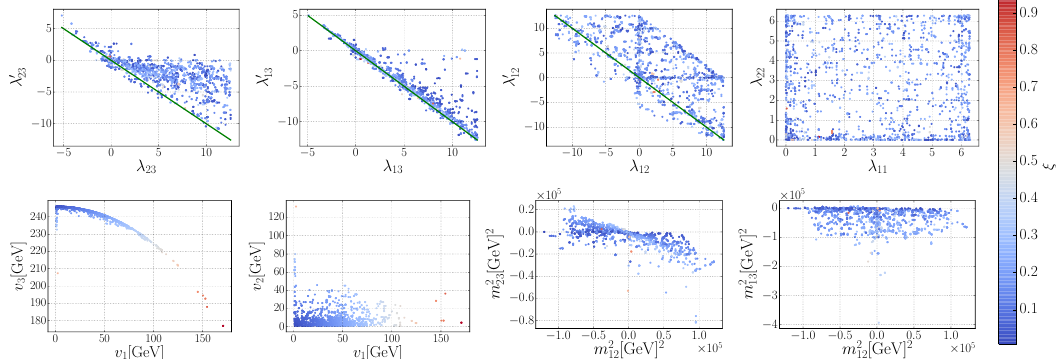
Figure 7 . Distribution of di(cid:11)erent parameters and (cid:24) values for points in the discovery region found by the Genetic Algorithm. The green solid line in the (cid:12)rst three plots indicates when (cid:21) ij =